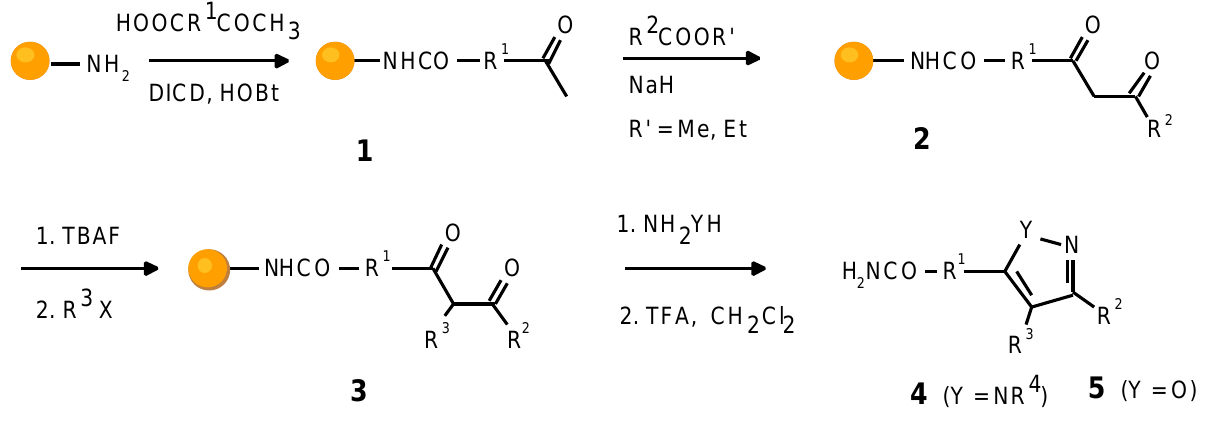
Scheme 1. Sequence of reactions generating molecular